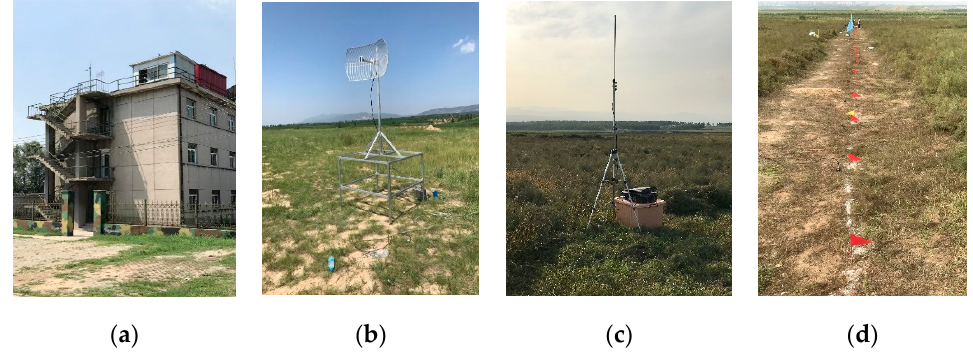
Figure 26. Field layout of the control distance of wireless sensor nodes: ( a ) main control station, ( b ) field transmitting antenna, ( c ) wireless AP, and ( d ) test site node layout.